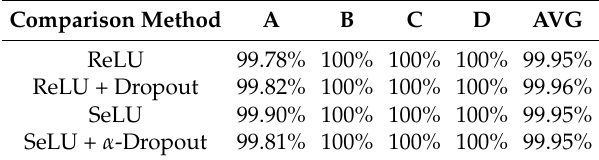
Table 6. Effects of SeLU and α -dropout on the diagnostic performance of 1D-SCNN.